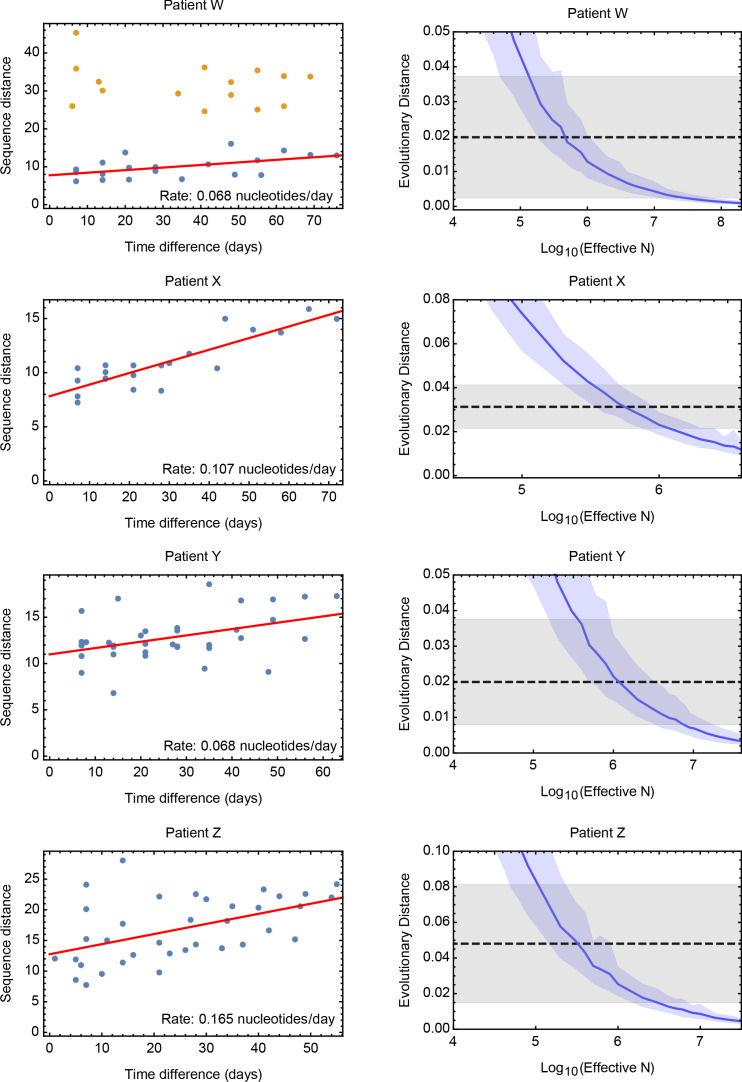
Estimates of the effective population size for data from a study of long-term influenza A/H3N2 infection in four patients.Patients are denoted with the letters assigned them in the original study (Xue et al., 2017). Rates of evolution within each patient were calculated by linear regression, conducted on a plot of evolutionary versus temporal distance between samples. The inferred regression line is shown in red for each dataset. For Patient W samples collected at two time points appear as outliers in the distance plot; distances involving these samples, shown in yellow, were excluded from the calculation. Accompanying plots show distances inferred via simulation compared to the inferred rates. A solid blue line shows the mean, with shading indicating an approximate 97.5% confidence interval around the mean. Statistics were calculated from sets of 400 simulations conducted at each value of Ne.Figure 2—figure supplement 3—source data 1.Sequence distances D calculated for the Xue et al dataset.Equivalent distances for a single generation generated from simulated data at different effective population sizes are also provided. The calculated equivalent distance per generation from the sequence data is also provided.